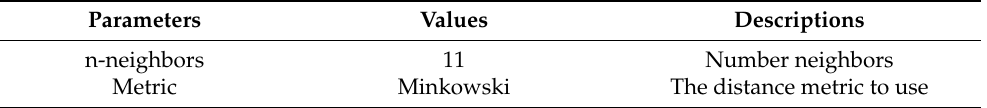
Table 4. Optimized KNN hyperparameters.